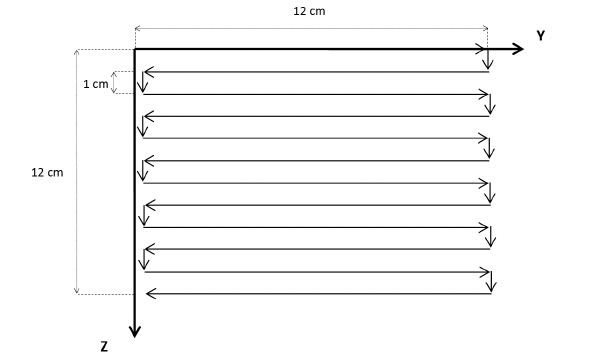
Figure 4. The scheme of the route of 6 Li + Si detector.